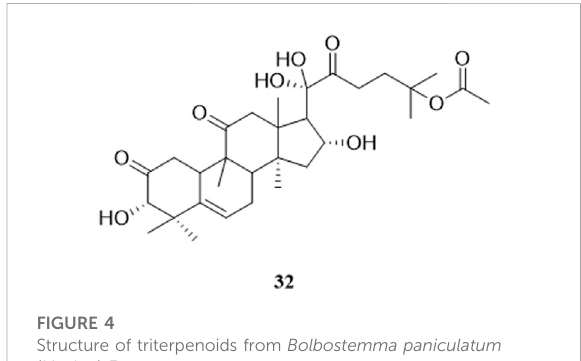
FIGURE 4 Structure of triterpenoids from Bolbostemma paniculatum (Maxim.)